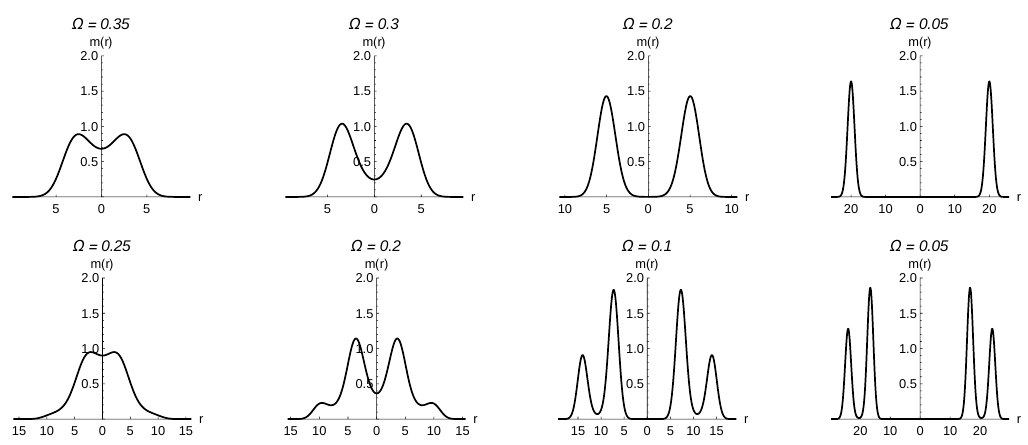
Figure 4 . Cross-sections of the mass density m for black ripples leading to black rings corresponding to the zero modes N = 2 ; 4, at di(cid:11)erent values of (cid:10). Close to the branching points the solutions develop bumpy deformations whereas far away from it the solutions closely resemble separated black rings. The (expected) pinching of the necks as we move away from the MP-branch follows a behavior described already in [40]: for multiple rings the pinching starts at the interior necks and later on the outer ones.